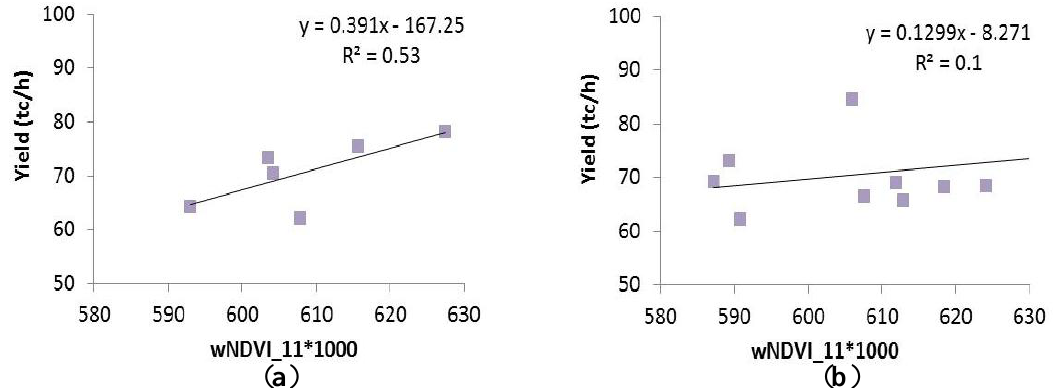
Figure 5. Variability with wNDVI_11 averaged ( a ) at zone level on the 2002–2010 periods, and ( b ) at annual level on the six